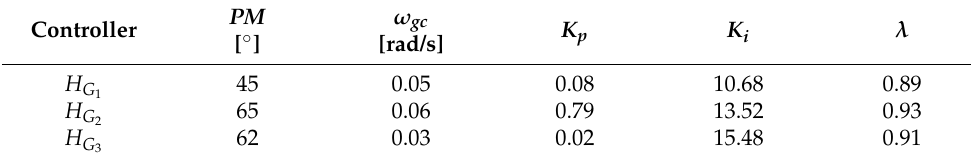
Table 2. The imposed performances and the resulting FO-PI controller parameters.